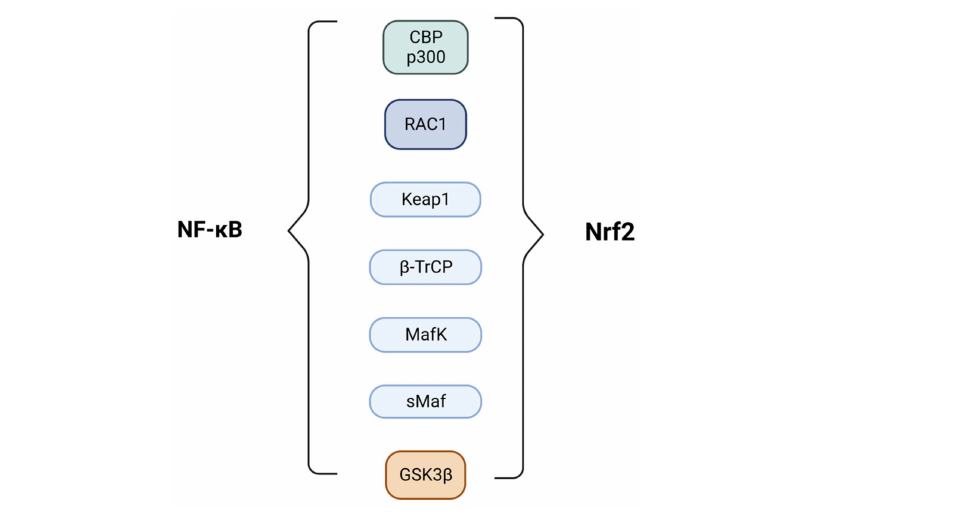
Figure 4. Main transcriptional factors and proteins involved in the Nrf2/NF-kB